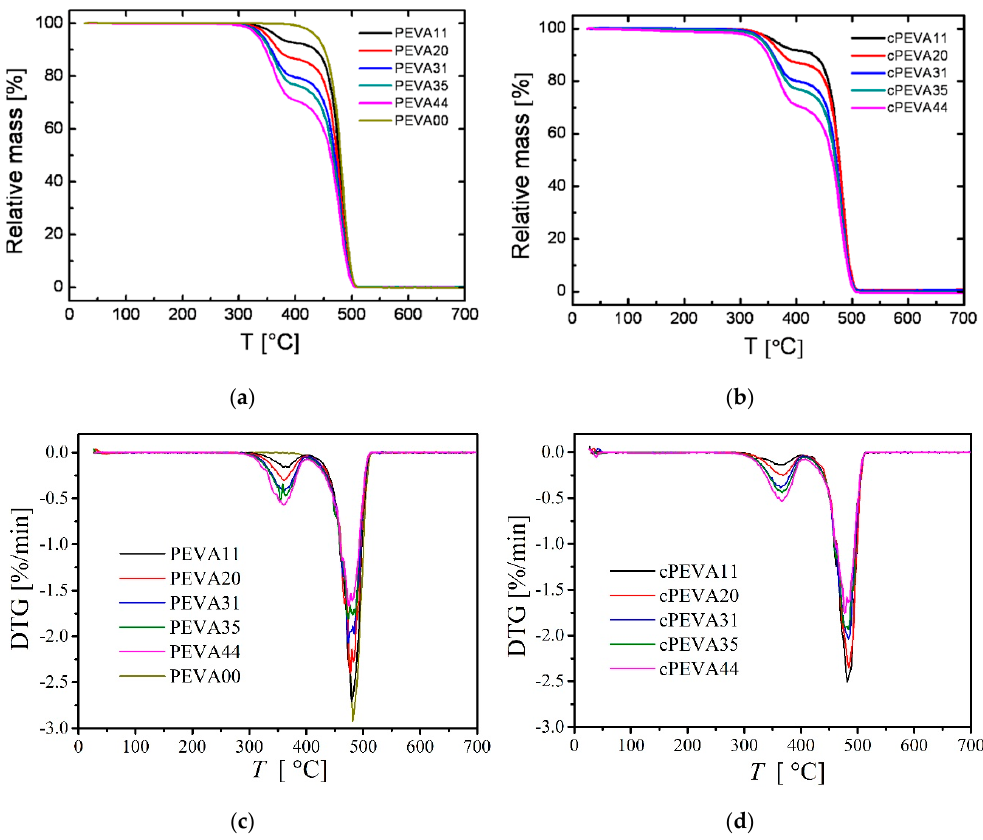
Figure 2. Thermal stability of polyethylene homopolymer (PEAV00), PEVAs ( a ) and cPEVAs ( b ) with varied vinyl acetate contents determined by TGA and derivative thermogravimetric (DTG) of polyethylene homopolymer (PEAV00), PEVAs ( c ) and cPEVAs ( d ) with temperature from 25 °C to 700 °C, at a heating rate of 20 °C·min − 1 .